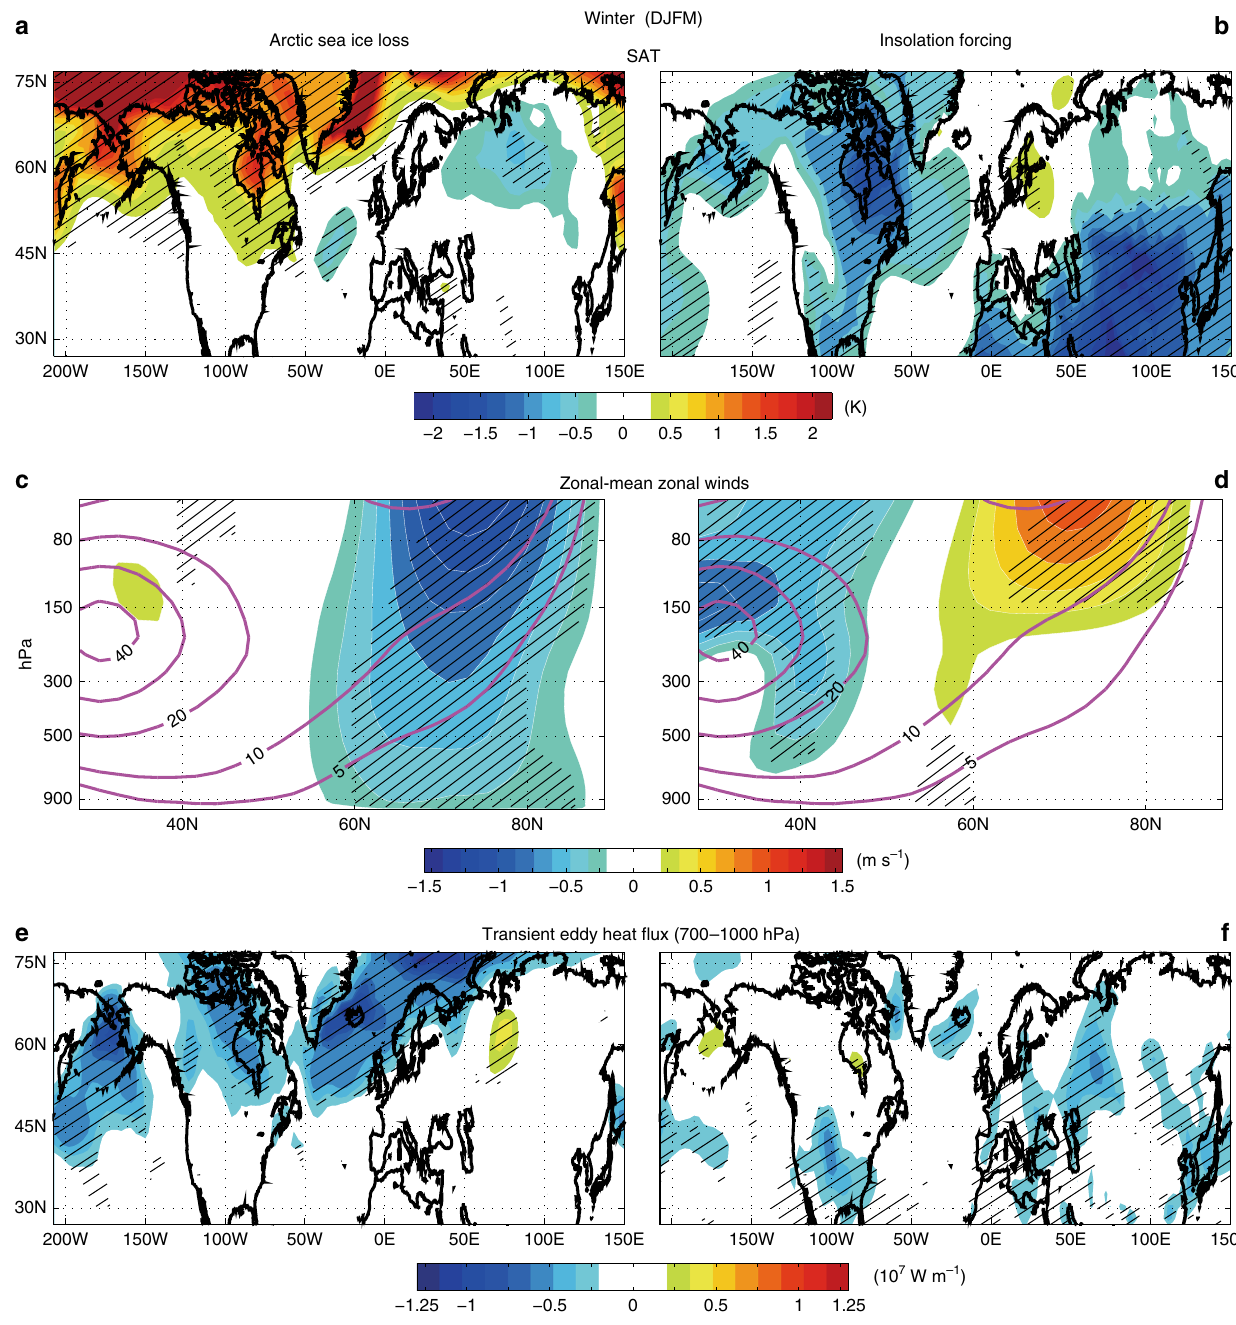
Fig. 3 Wintertime responses of temperature, westerly winds, and storm tracks. The wintertime (December – March) responses of a , b surface air temperature (K), c , d zonal-mean zonal winds (m s − 1 ) and e , f transient eddy heat fl ux (10 7 W m − 1 ) to mid-Holocene Arctic sea ice loss ( a , c , e ) and insolation forcing ( b , d , f ). Purple lines in c and d are climatological-mean zonal-mean zonal winds from the mid-Holocene with pre-industrial sea ice simulation. In e and f , the transient eddy heat fl ux at each pressure level is integrated from the surface to 700 hPa. For all the plots, statistically signi fi cant values ( p < 0.05) are